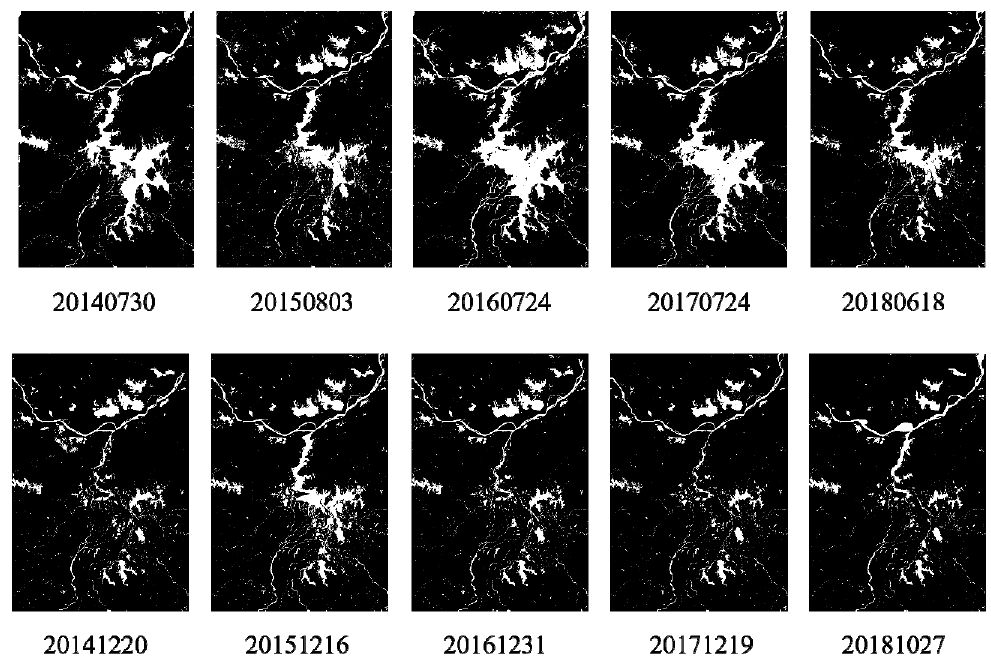
Figure 9. The spatial variations of water area in summer and winter of 2014–2018 in Poyang Lake area based on DenseNet. The first row shows the lake areas in summer and the second row shows those in winter. White color indicates the identified water bodies.